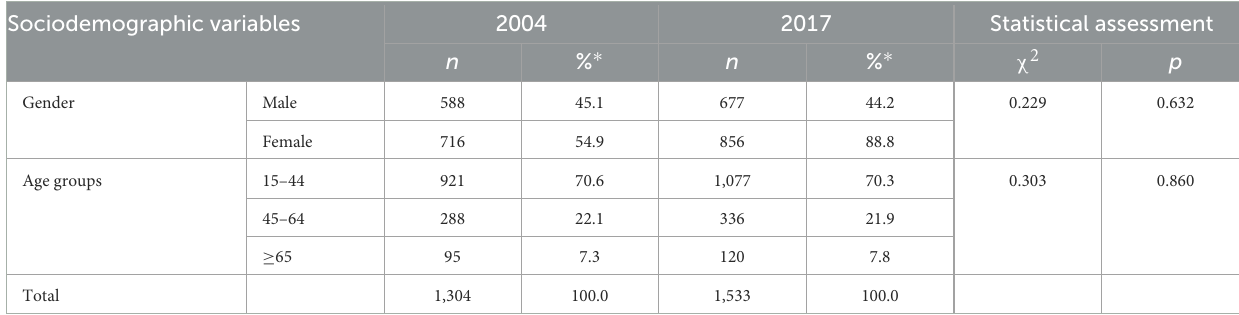
TABLE 1 Distribution of gender and age groups of the respondents in 2004 and